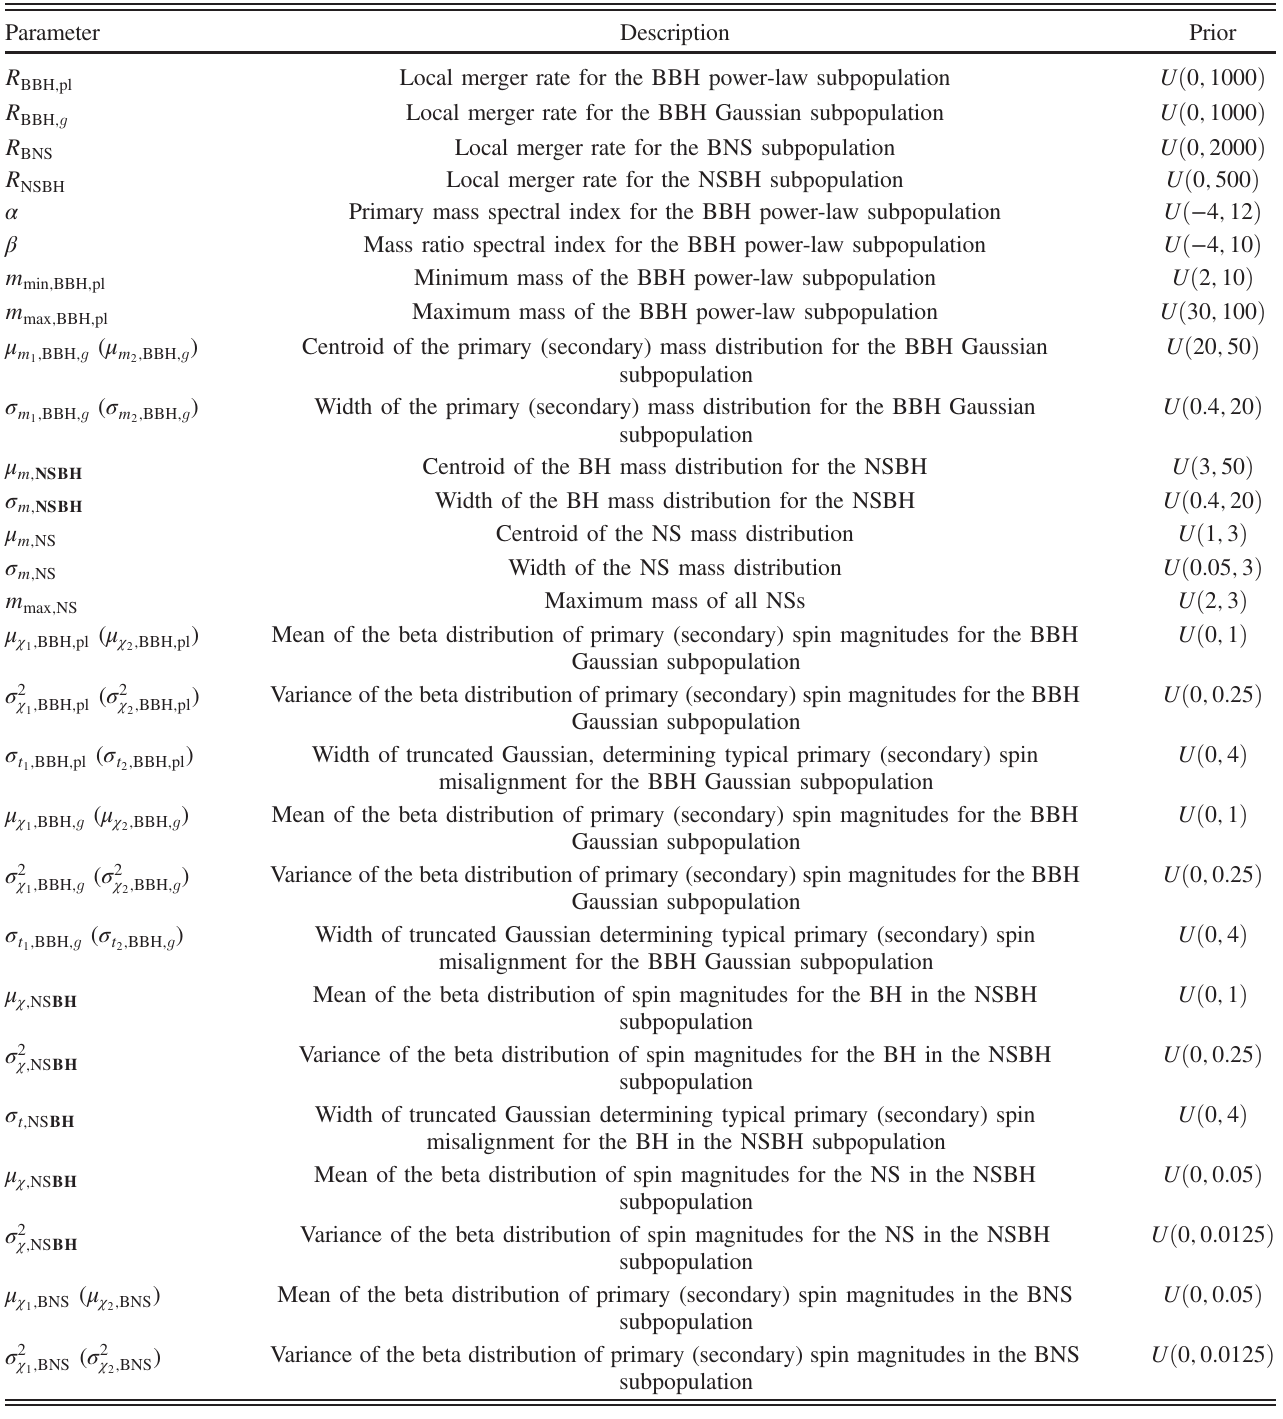
TABLE XIV. Summary of M ULTI SOURCE model parameters. All rates are in Gpc − 3 yr − 1 , and all masses in M ⊙ . Rate, mass, and spin hyperparameters are separated by horizontal